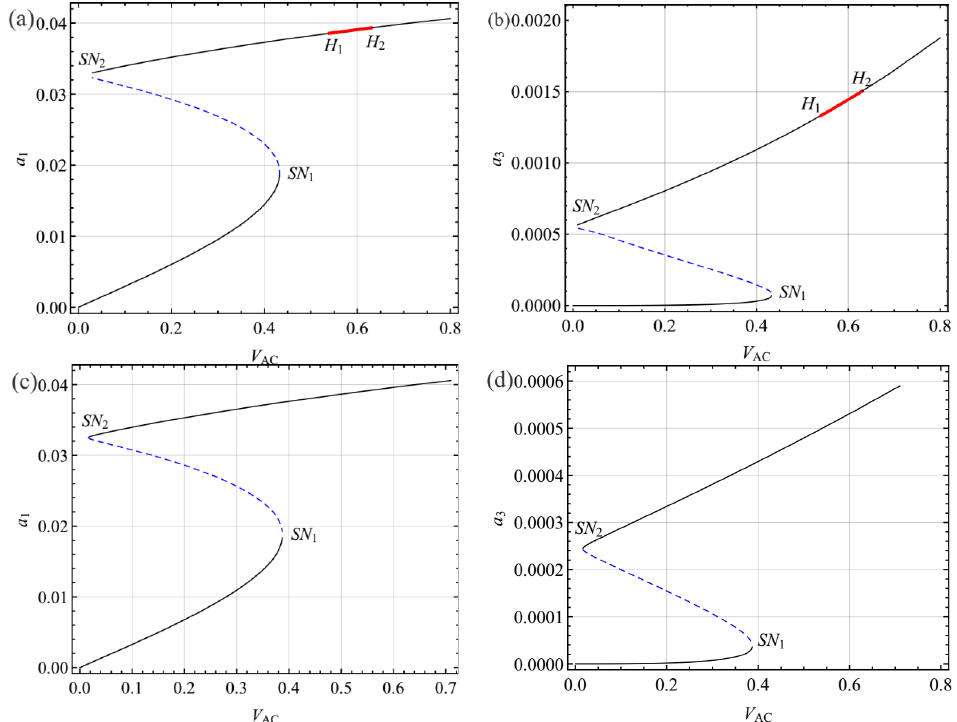
Figure 7. Variation of force response curves for various values of the internal detuning parameters for σ 2 = −0.3: ( a , b ) V DC = 28.00, σ 1 = 0.005; ( c , d ) V DC = 30.80, σ 1 = 0.6307. σ = − 0.3: ( a , b ) V = 28.00, σ = 0.005; ( c , d ) V 2 DC 1